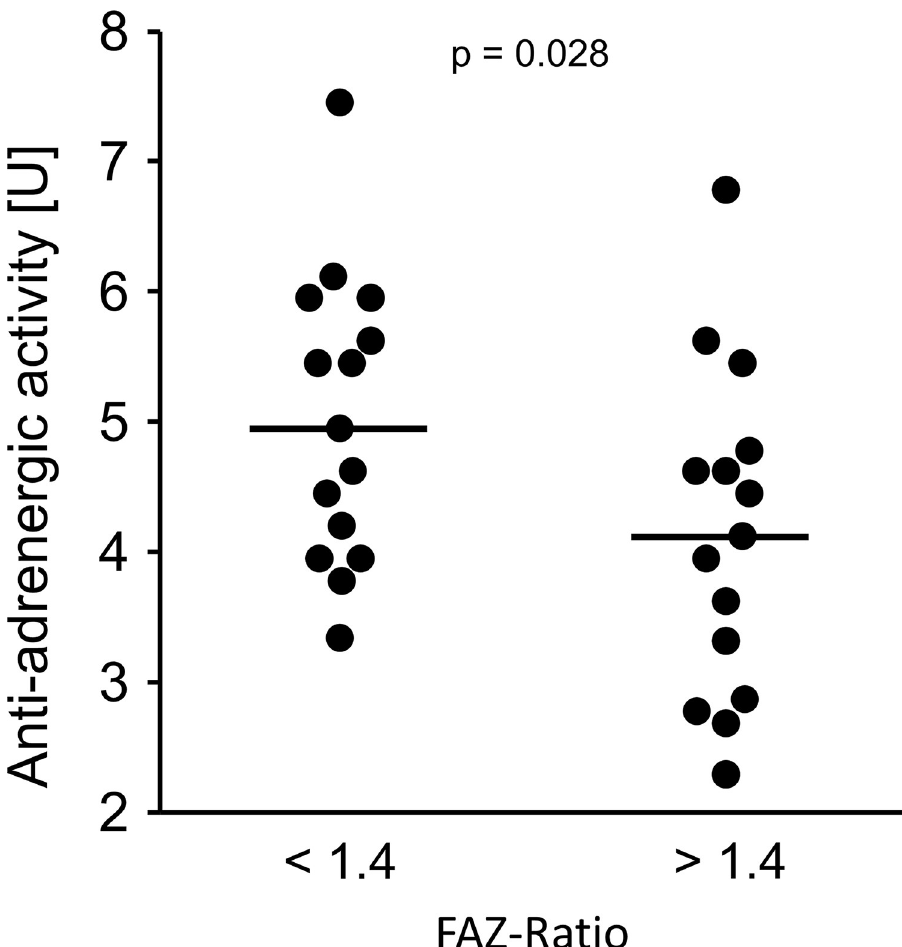
Fig 5. Anti-adrenergic activity β 2-agAAb [U] considering FAZ-ratio (cutoff 1.4; p = 0.028), plotted as raw data and median.